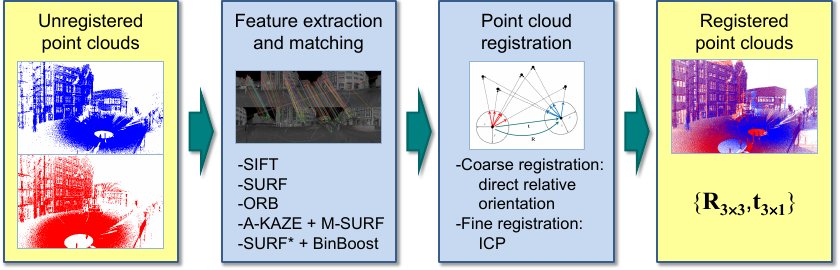
Figure 1. The proposed framework for keypoint-based point cloud registration and the involved methods for each component. strings from image patches. In this context, the individual bits are obtained from a set of binary tests based on comparing the inten- sities of pairs of points along specific lines. The modification re- sulting in the ORB descriptor consists of steering BRIEF accord- ing to the orientation of keypoints and thus deriving a rotation- aware version of the standard BRIEF descriptor. The similarity of such binary descriptors can be evaluated by using the Ham- ming distance, which is very efficient to